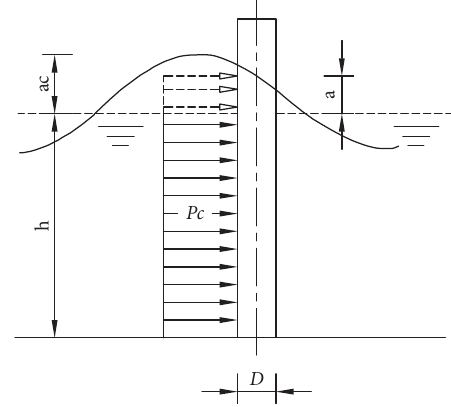
Figure 16: Sketch to define the force acting on the wharf